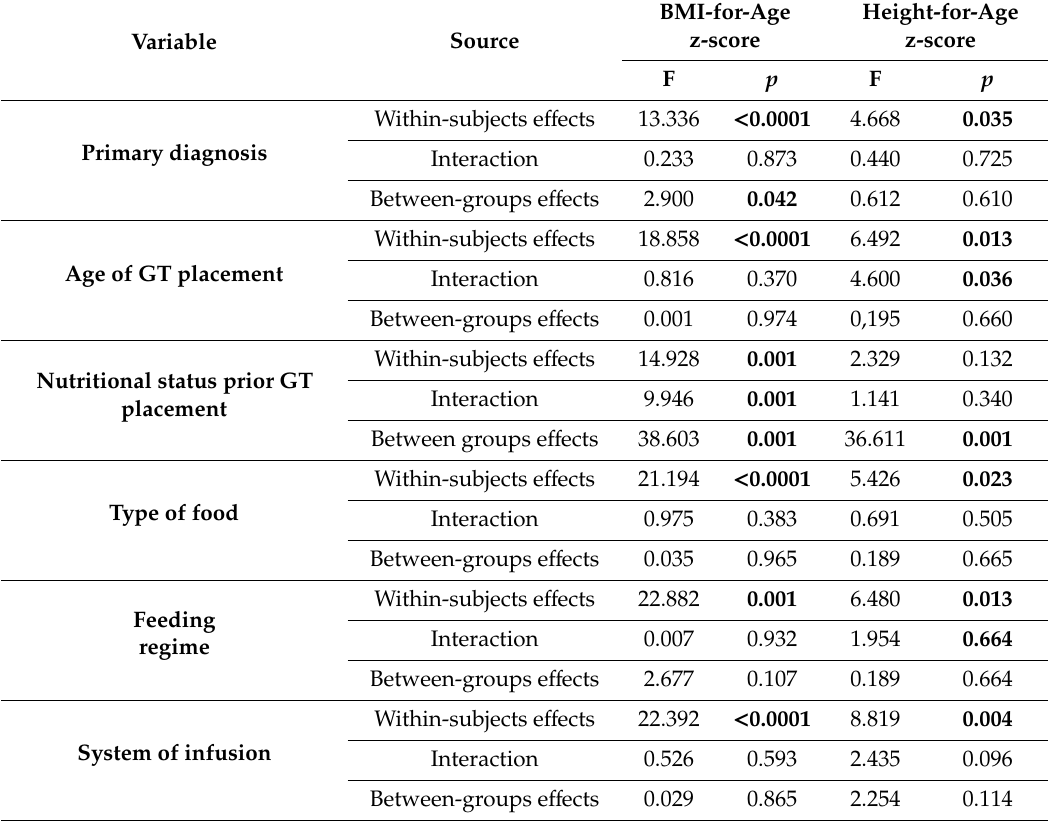
Table 3. Summary of the e ff ects for the anthropometrics variables (ANOVA of repeated measures) over